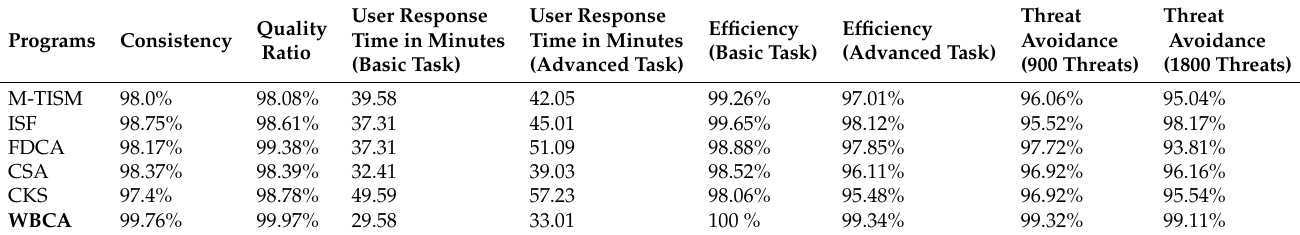
Table 2. Comparative Analysis of the proposed WBCA and contending programs: (M-TISM, ISF, FDCA, CSA, and CKS). Quality Programs Consistency